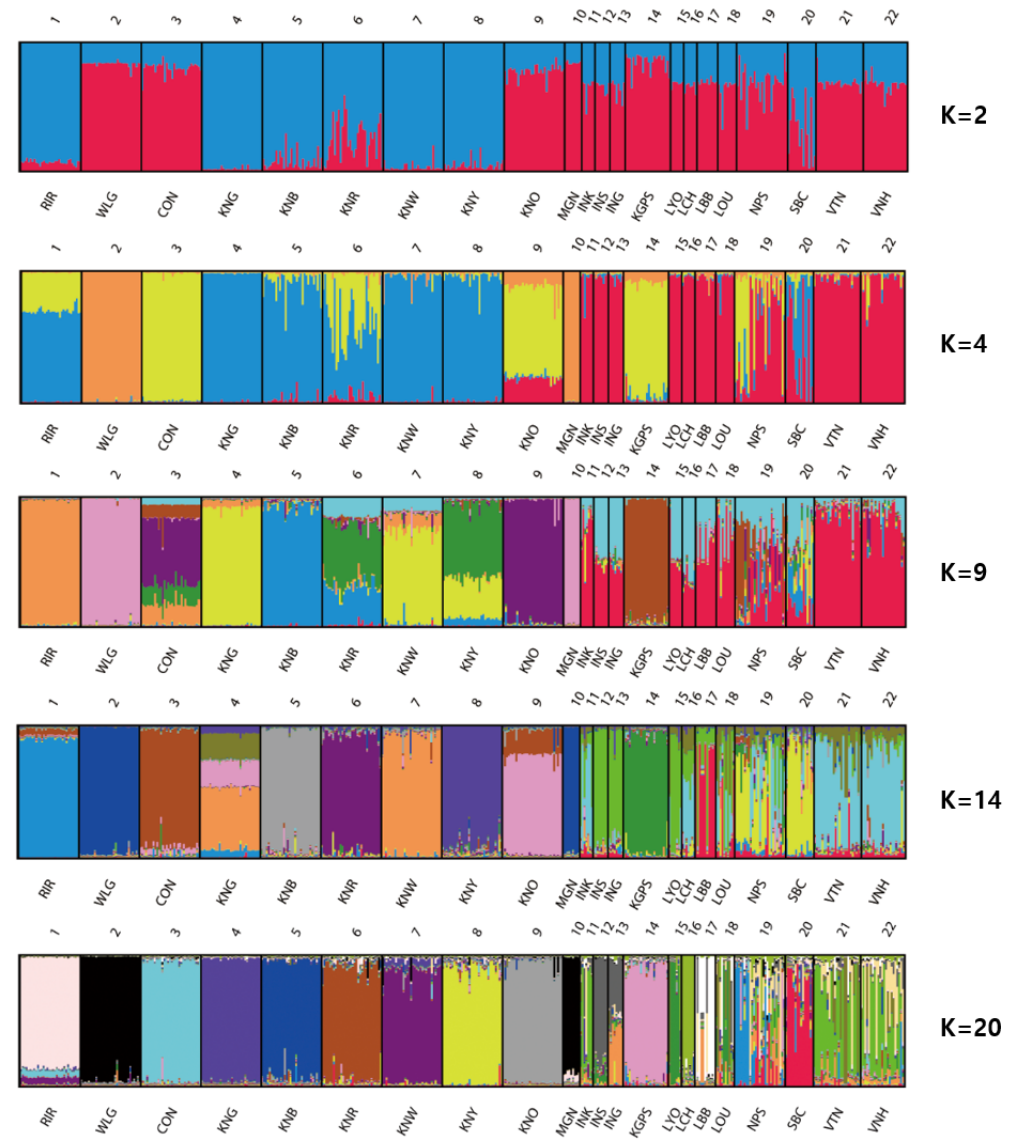
Figure 2. Clustering assignment of the 22 chicken breeds obtained by STRUCTURE analysis. Each of the 469 chickens is represented by a thin vertical line, which is divided into colored segments which represent the proportional contribution of the inferred K = 4, 9, 14, 20 clusters. The populations are separated by thin vertical black lines. RIR, Rhode Island Red; WLG, White Leghorn; CON, Cornish; KNG, Korean Grayish-brown; KNB, Korean Black; KNR, Korean Reddish-brown; KNW, Korean White; KNY, Korean Yellowish-brown; KNO, Korean Ogye; MGN, Mongolian Nuthiin bor; INK, Indonesian KUB; INS, Indonesian Sensi; ING, Indonesian Gaok; KGPS, Kyrzyzstani GPS-H; LYO, Laotian York; LCH, Lotian Chae; LBB, Laotian Black Bone; LOU, Latotian Ou; NPS, Nepalese Sakini; SBC, Sri Lankan